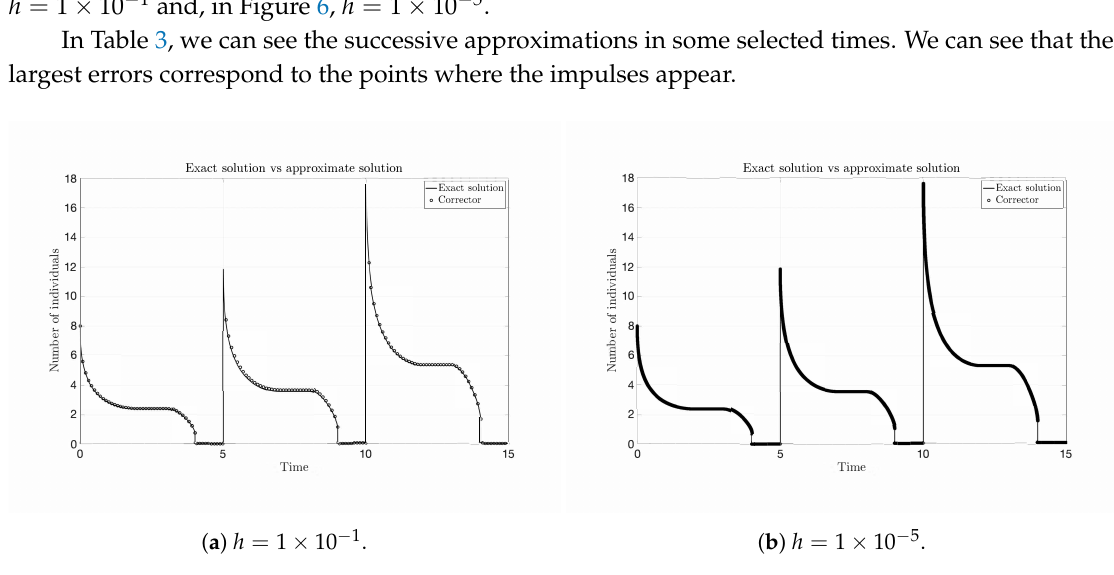
Figure 5. Exact solution vs. approximate solution. Observe that in ( b ), the match is perfect, and the circles indicating the corrector are so close together that they look like a continuous stroke. Vertical lines indicate jumps. Table 3. Numerical results at some selected times (silkworm population